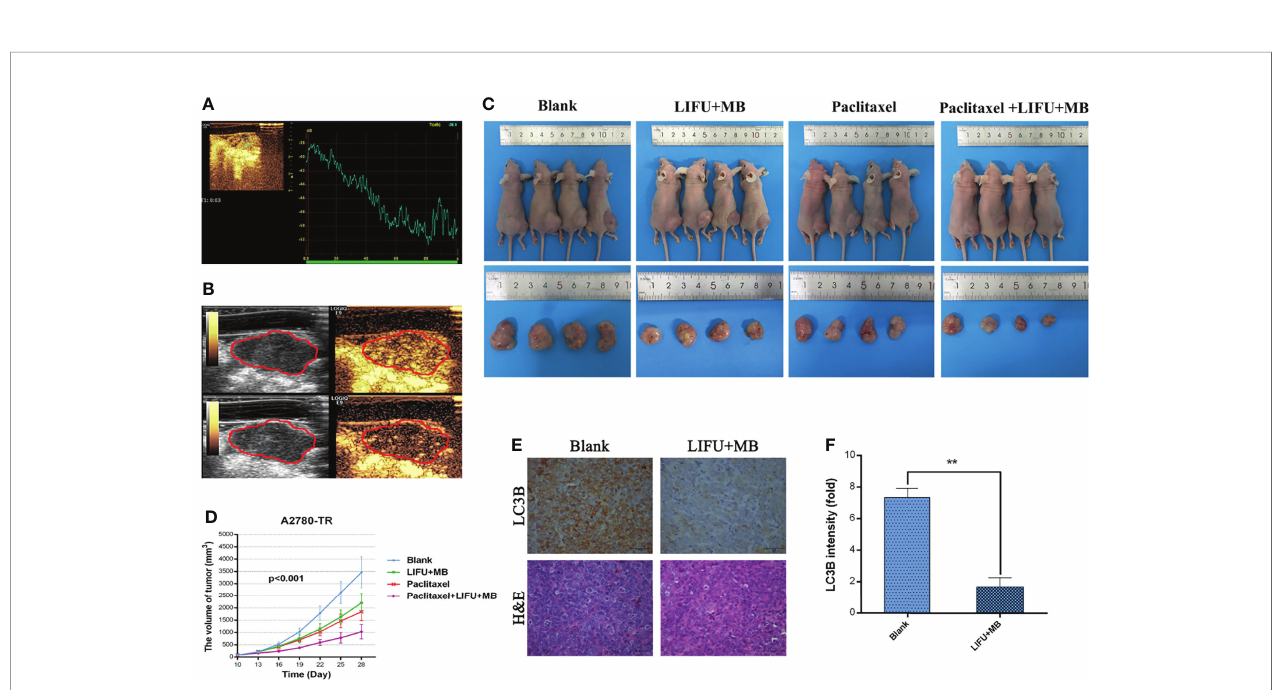
FIGURE 8 | The effects of different treatments on the tumor-induced nude mice. (A) Contrast-enhanced ultrasound with time – intensity curve. (B) Preliminary assessment of tumors in mice, images at 15 s and 2 min after administration of 0.1 ml microbubble. (C) LIFU+MB signi fi cantly inhibited subcutaneous tumor growth in mice treated with paclitaxel. (D) Growth curve of A2780-TR subcutaneous xenograft tumors. (E, F) LC3B expression analyzed by immunohistochemistry in tumor tissues and quanti fi ed. Scale bar: 50 m m (×400). (**p < 0.01, n = 3, student t-test, means ± 95%